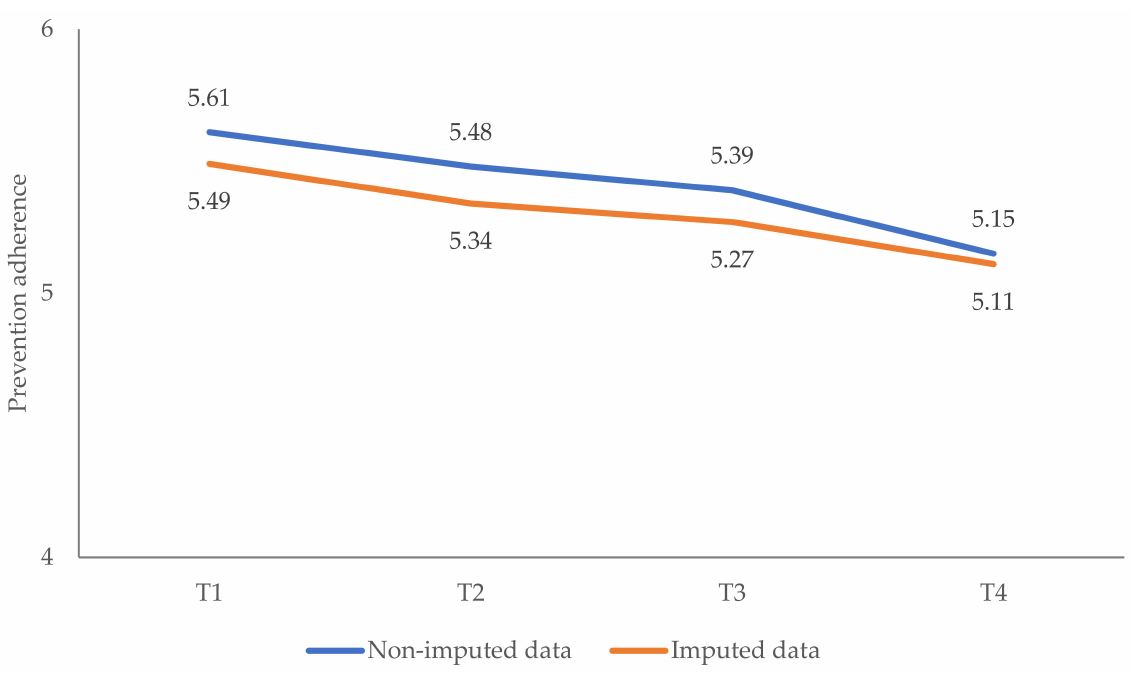
Figure A7. Changes over time in the subscale “Prevention adherence”: imputed vs. non-imputed results. Note: Imputed dataset: n = 1001. Non-imputed dataset: n =